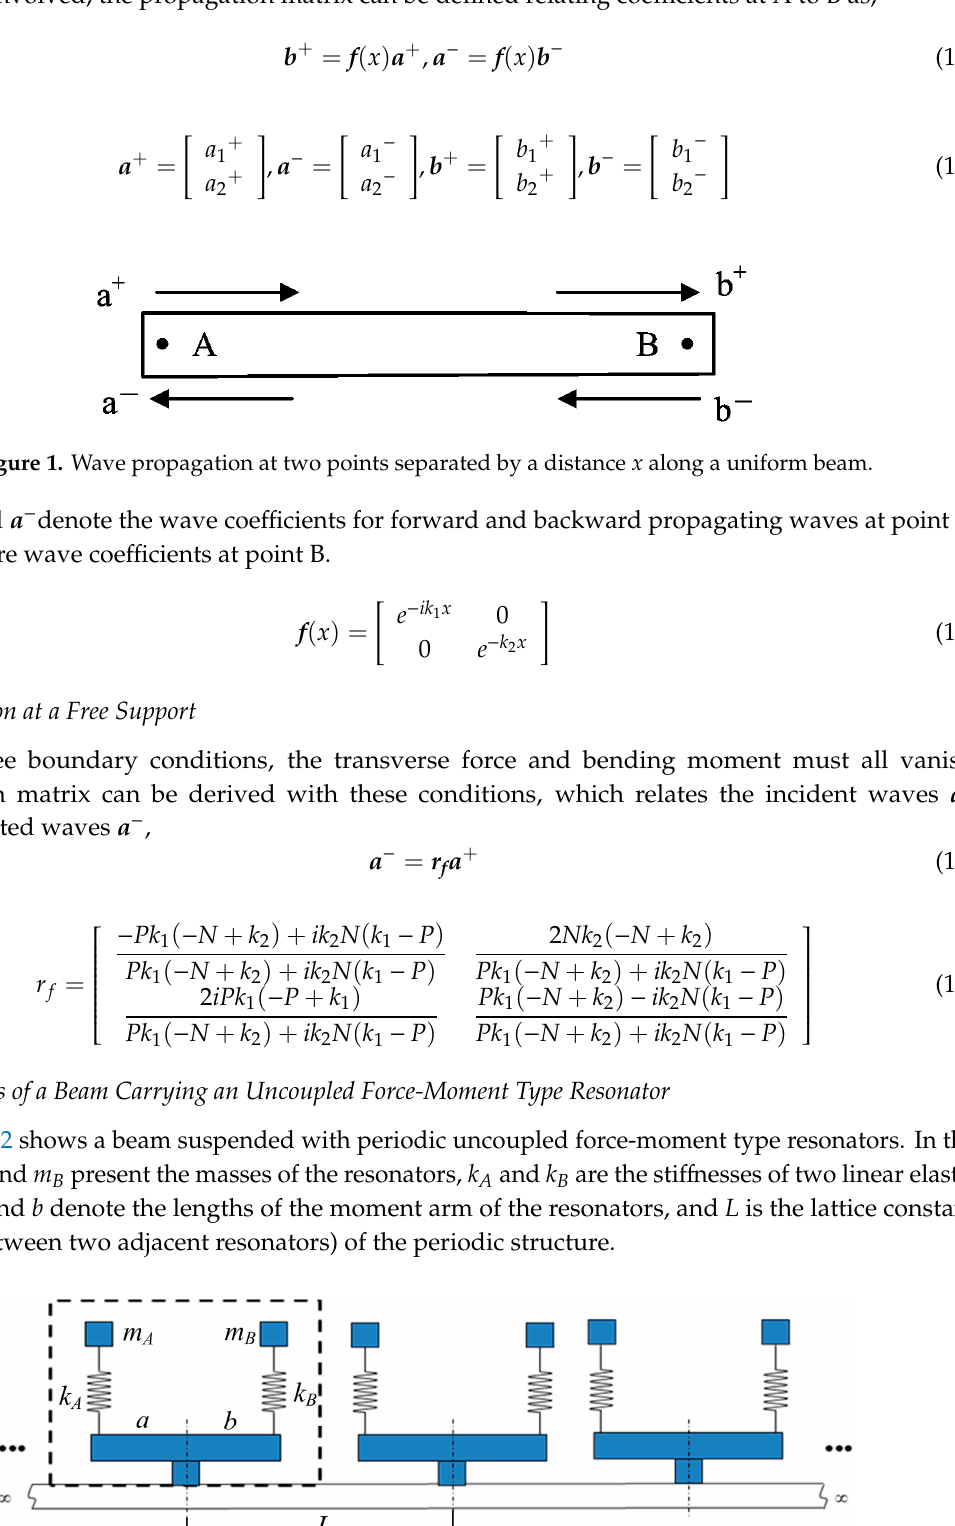
Figure 2. A beam with periodic uncoupled force-moment type resonators.